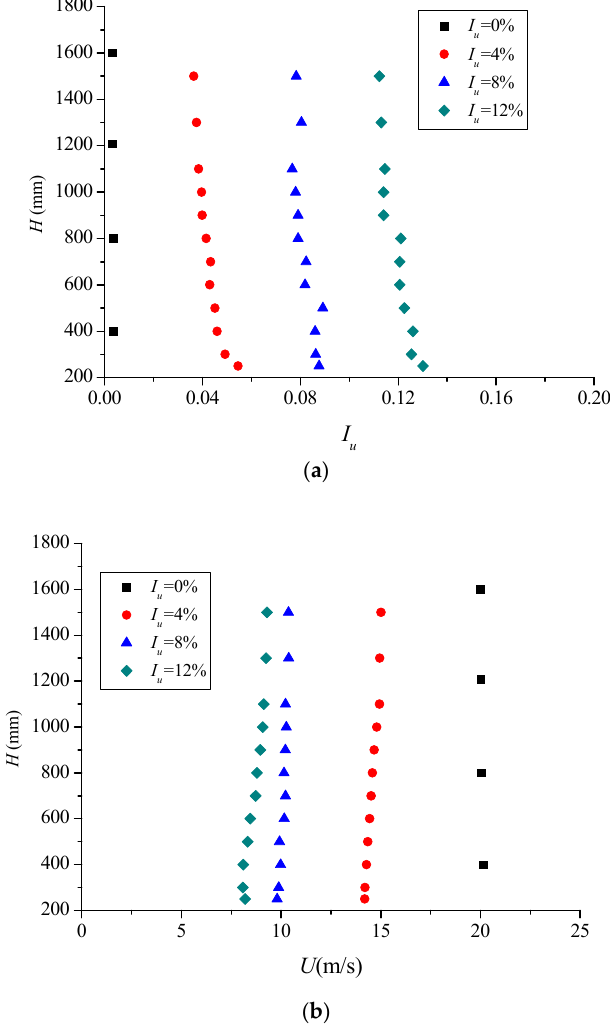
Figure 2 . Four types of flow fields simulated in wind tunnel. ( a ) Turbulence intensity; ( b ) wind speed.